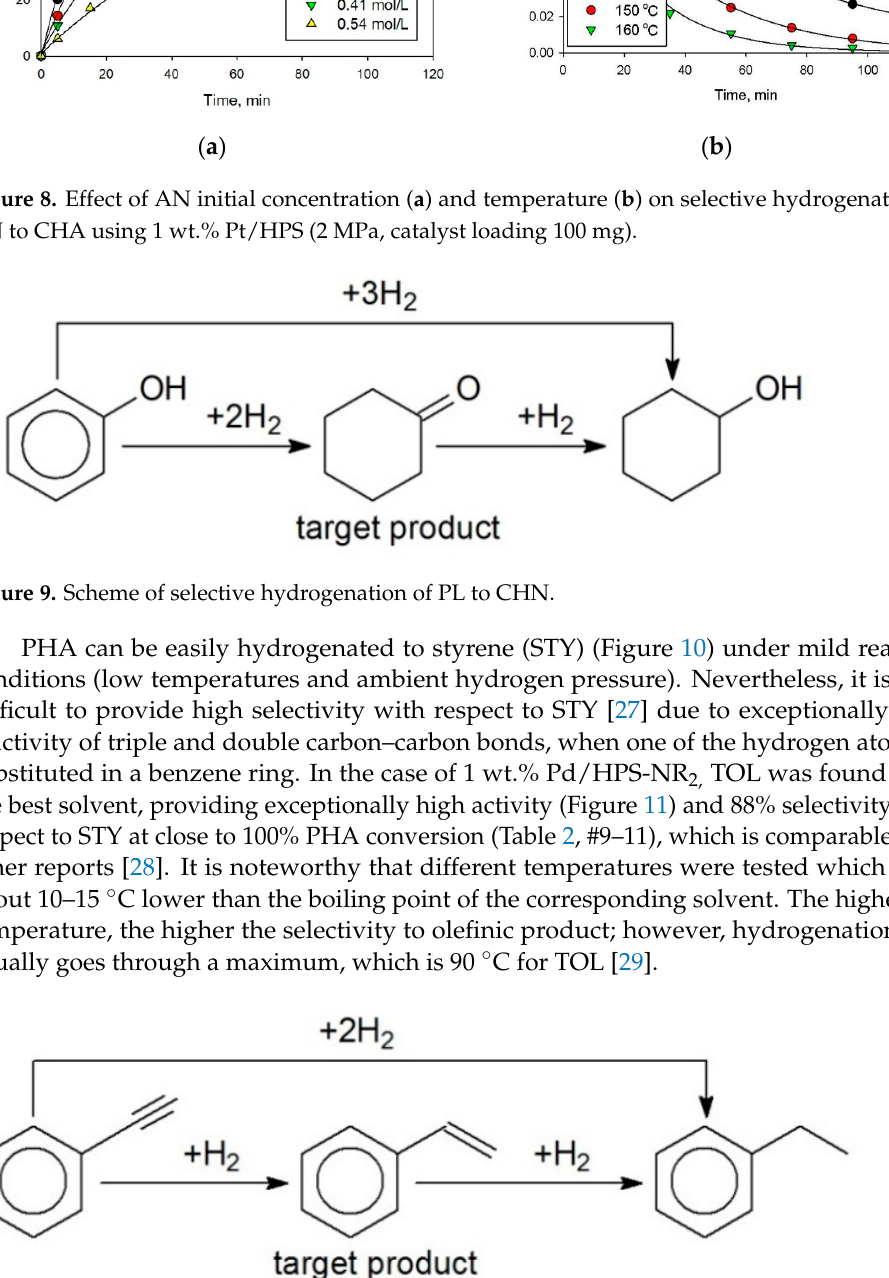
Figure 11. Solvent effect on PHA hydrogenation to STY over 1wt.% Pd/HPS-NR 2 (ambient H 2 pressure, C PHA ,0 = 0.48 mol/L, catalyst loading 30 mg). PP was also hydrogenated using Pd-containing catalyst (1wt.% Pd/HPS-NR 2 ). Phe- nylpropanol (PPL) was found to be the main reaction product (Figure 12). Figure 12. Scheme of selective hydrogenation of PP to PPL. Variation of overall pressure (Figure 13a) allowed determining the formal kinetic parameter with respect to hydrogen, which was close to the unit. The study of the tem- perature effect was carried out at 0.25 MPa (Figure 13b). It was found that the reaction rate increased with the increase of temperature from 60 °C up to 80 °C (in this range, E a,app = 75 ± 5 kJ/mol, calculated taking into account the same assumptions as in the case of BZ hydrogenation). Further increase of temperature resulted in noticeable decrease of the PP hydrogenation rate due to the high vapor pressure of the solvent (hexane). Thus, 80 °C can be considered as the optimal temperature (see also Table 2, #12), which provided 98% conversion of PP (for 240 min) and exclusive formation of PPL (100% selectivity).